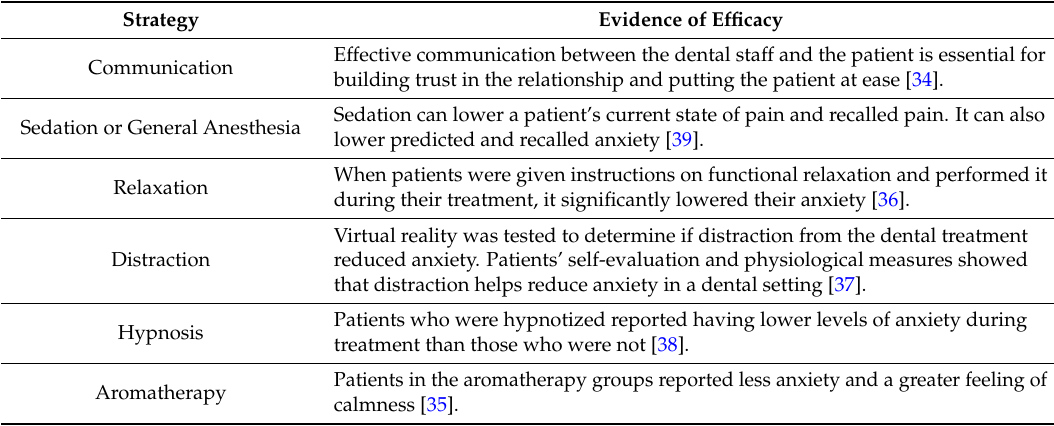
Table 2. Strategies to manage anxiety in a dental